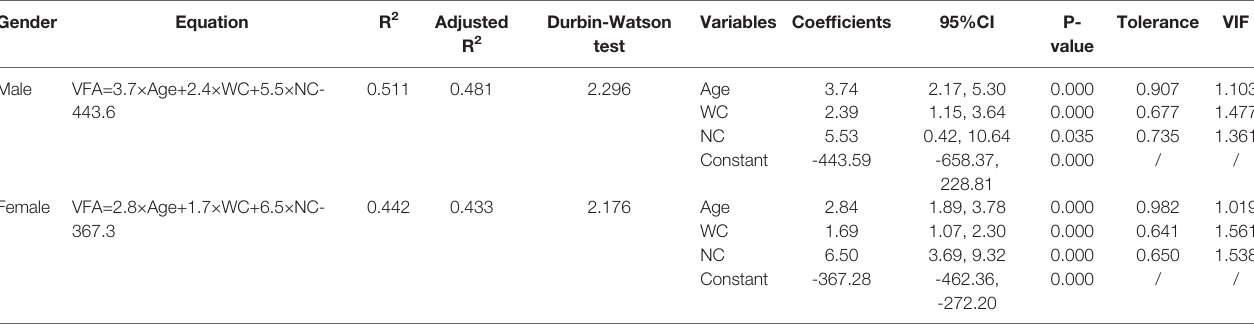
TABLE 3 | The establishment of new equations in male and female groups respectively. Gender